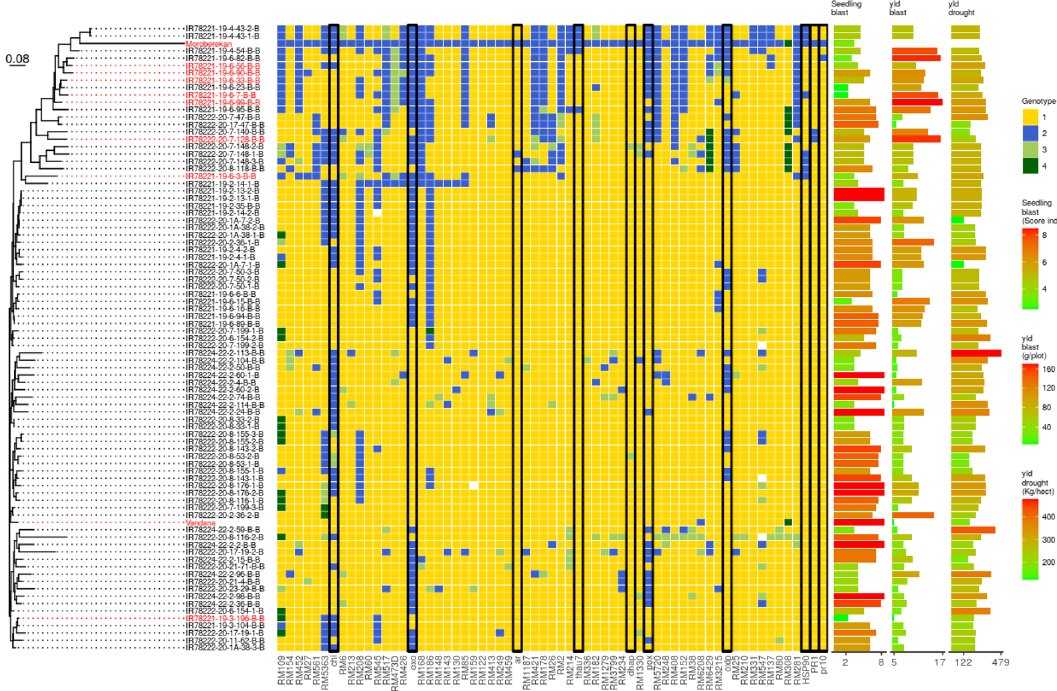
Figure 3. Neighbor-joining tree generated by calculating Gower distances between genotypes of F 6 intermated lines based on the similarity to the population’s parents (left panel). Genotyping of intermated lines using 60 SSR markers spanning five chromosomes (see Fig. S3 for reference) and ten CG markers (black box highlight) shows greater similarity to Vandana (1—yellow) than Moroberekan (2—blue); some regions were heterozygous (3—light green), while others did not fit the above classes (4—dark green) (center panel). Lines accumulating Moroberekan regions performed better under seedling blast conditions in Almora (right panel). The same lines showed higher yields under heavy blast conditions. Performance under drought at IRRI is consistent with the parent Vandana. Chi (Chitinase), OXO (Oxalate Oxidase), ar (Aldose reductase), thau7 (Thaumatin like), pox